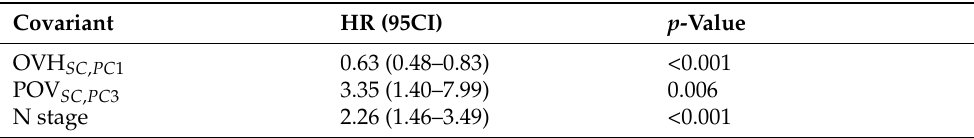
Figure 2. Continuous and binarized spatial factor distributions and N stage distributions for 3-year disease progressed and non-disease progressed patients in the discovery and validation cohort. ( a ) Box plots of continuous spatial factor distributions. Patients with disease progression within three years had lower mean OVH principle values and higher mean POV principle values at both discovery and validation. ( b ) Mosaic plots of the binarized spatial factor and N stage distributions of patients with and without 3-year disease progression. Table 2. Hazard ratios and p -values of the selected spatial factors and N stage from multivariate Cox regression on disease-free